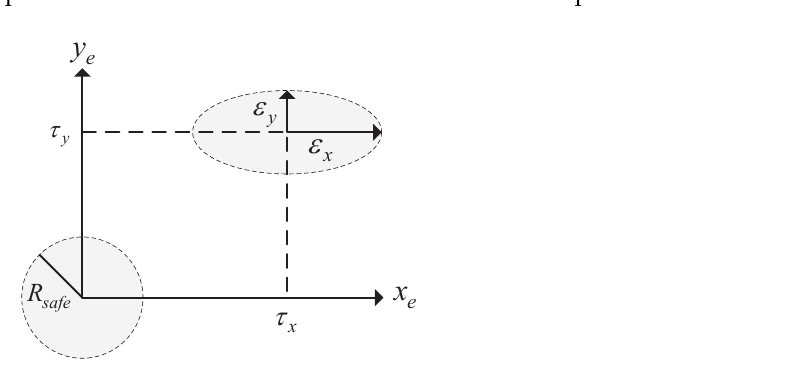
Figure 3. Schematic of the projection of the joint error ellipsoid in the rendezvous